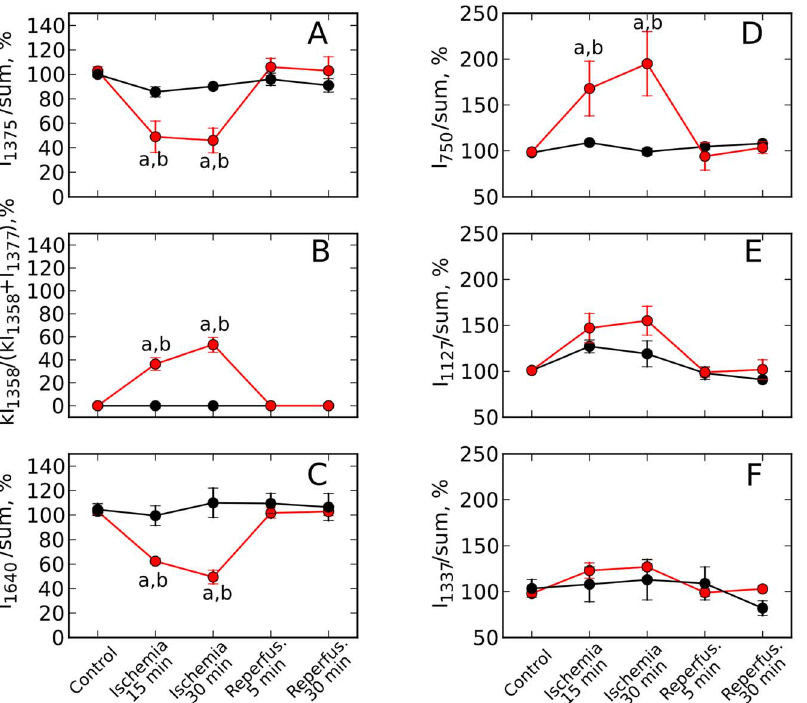
Figure 5. Effect of global ischemia on the amount of reduced cytochromes c,c1,b and oMb. Effect of global stop-flow ischemia on the normalized intensity of oMb peaks at 1375 and 1640 cm 2 1 (A and C), on the relative amount of dMb (B) and on the normalized intensities of peaks corresponding to reduced cytochromes c, c1 and b at 750 and 1127 cm 2 1 (D and E), and to cytochromes b at 1337 cm 2 1 (F). Red line and markers correspond to the data of global ischemia experiments, black line and markers — to the data of control experiments. Normalization of peaks was done to the sum of the whole spectrum intensities. Values are mean + SE (n=3). Nonparametric Kruskal-Wallis test with post Dunns multiple comparison test gives p v 0 : 05 between results for 0 min and ischemia (15 and 30 min) ( a ) and for 15 and 30 min of ischemia and corresponding time in the control experiment ( b ).